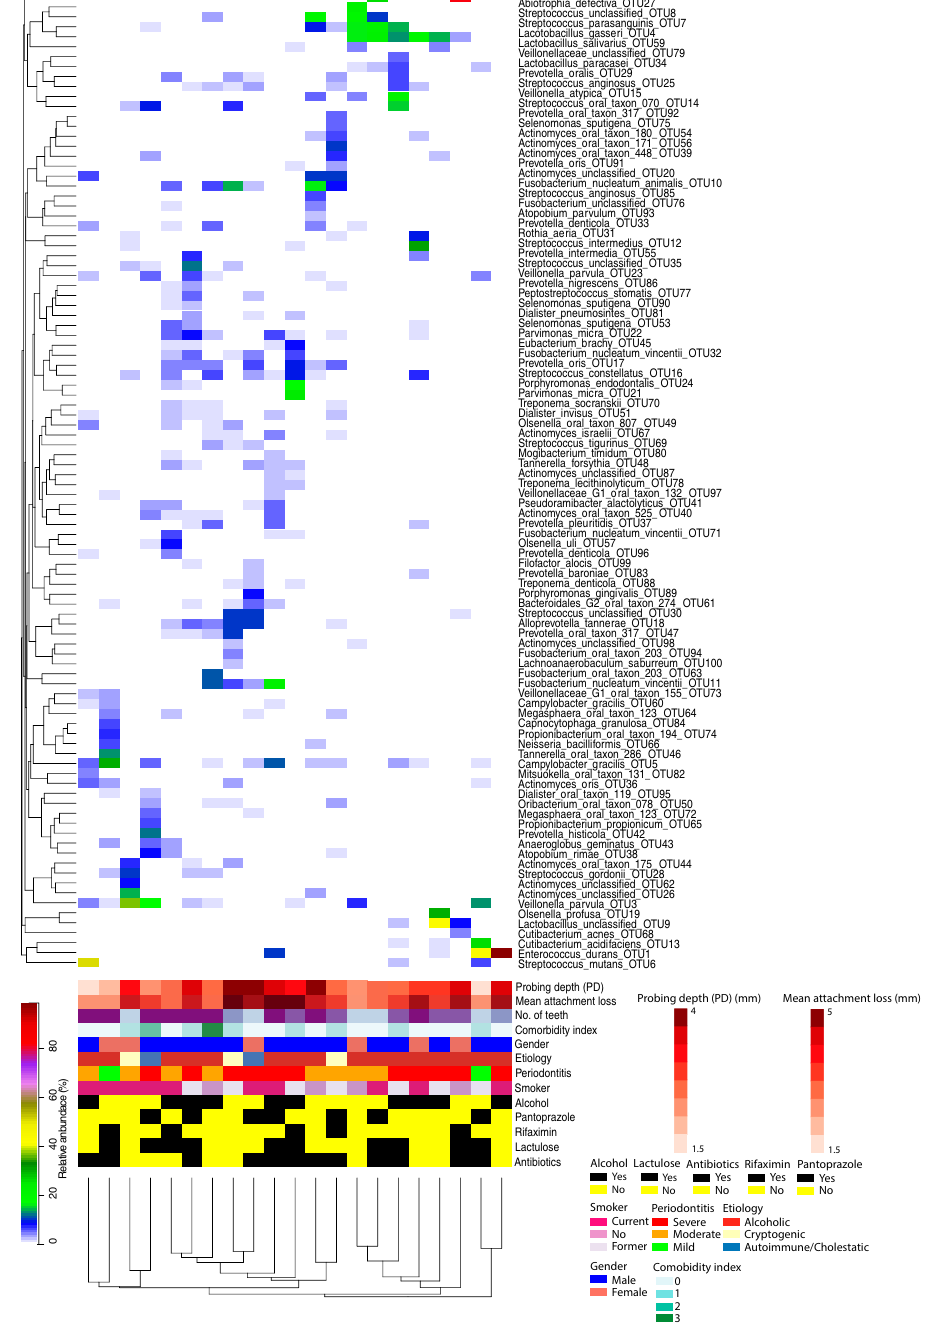
Figure 2. Heatmap of the relative abundances for the top 100 OTUs found in the subgingival microbial communities of the patients with periodontitis and liver cirrhosis. Patients are shown in rows, while OTUs appear in columns. Color scale for the heatmap is shown in the top left with the most abundant OTUs in red and the least abundant in white. Patients are organized according to results of hierarchical clustering (complete linkage) of microbial communities based on OTU relative abundances. Color bars in the left depict the medical and clinical characteristics for each patient. Color scales for metadata appear at the